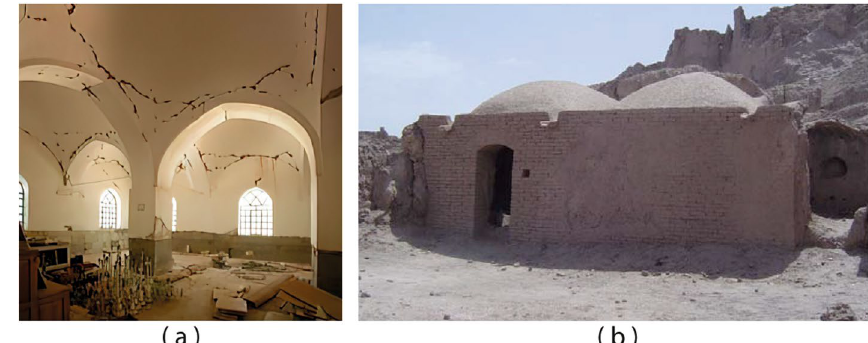
Fig. 19 Acceptable behaviour of curved roofs during the Bam earthquake: ( a ) an adobe dome that was damaged but did not collapse (Source: Langenbach 2010) and ( b ) an adobe dome without damage (Source: Mahdi 2004)